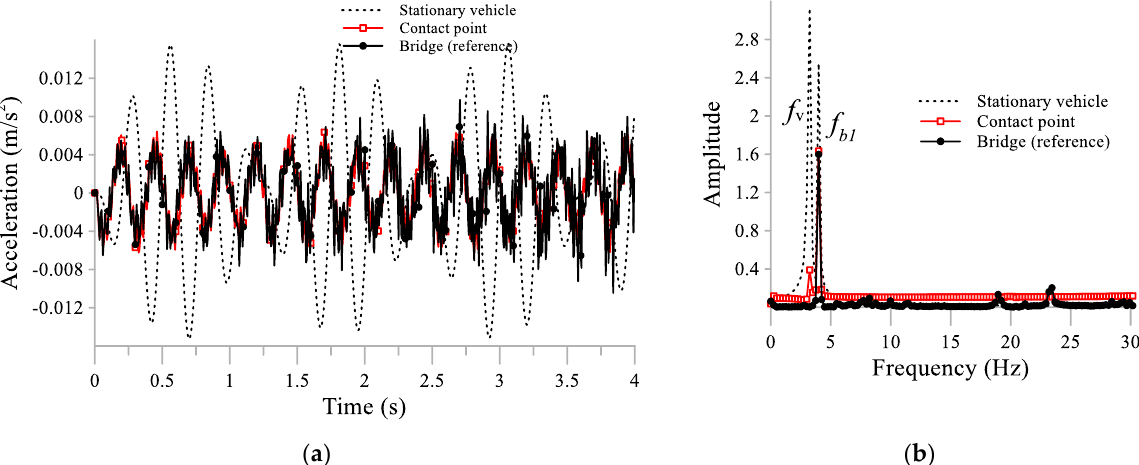
Figure 21. Dynamic responses for a moving vehicle with a mass of 7200 kg. ( a ) Acceleration response of the 3.18-Hz stationary vehicle, its contact-point, and the bridge, along with ( b ) the acceleration spectra.